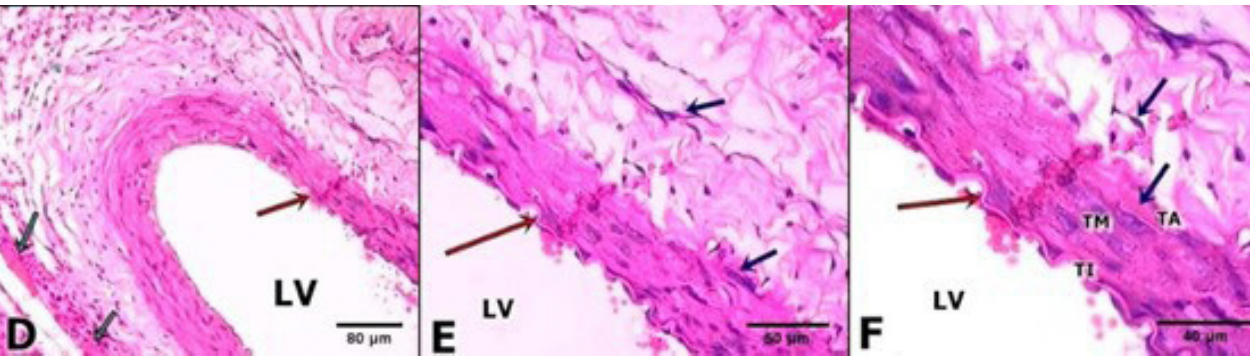
Fig. 1 - Photomicrographs of the region of surgical specimens extracted from samples 7 days after the operation, stained with HE. A, B and C belonging to the Control Group (GC). Note in Figure A, B and C, a greater amount of red blood cells in the vascular wall, and adjacent regions beyond the lumen of the vessel (LV). In A (10x magnification), the long red arrows point to the route of vascular injury (tunics with infiltrates of red blood cells and leukocytes, in addition to greater epithelial density). B (20x magnification) and C (40x magnification) detail the presence of red blood cells in the tunica media, with an infiltrate of leukocytes and fibroblasts.